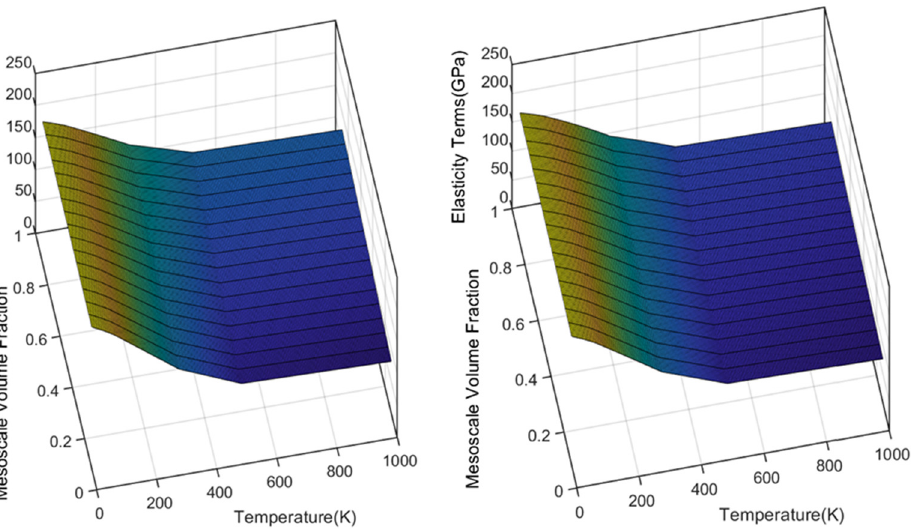
Figure 15: E ff ects of volume fraction of mesoscale homogenized Nb 3 Sn fi lament group and temperature on the global homogenized elasticity terms, ( Left ) D 11⁎ , ( Right ) D D 22⁎ 33⁎ (